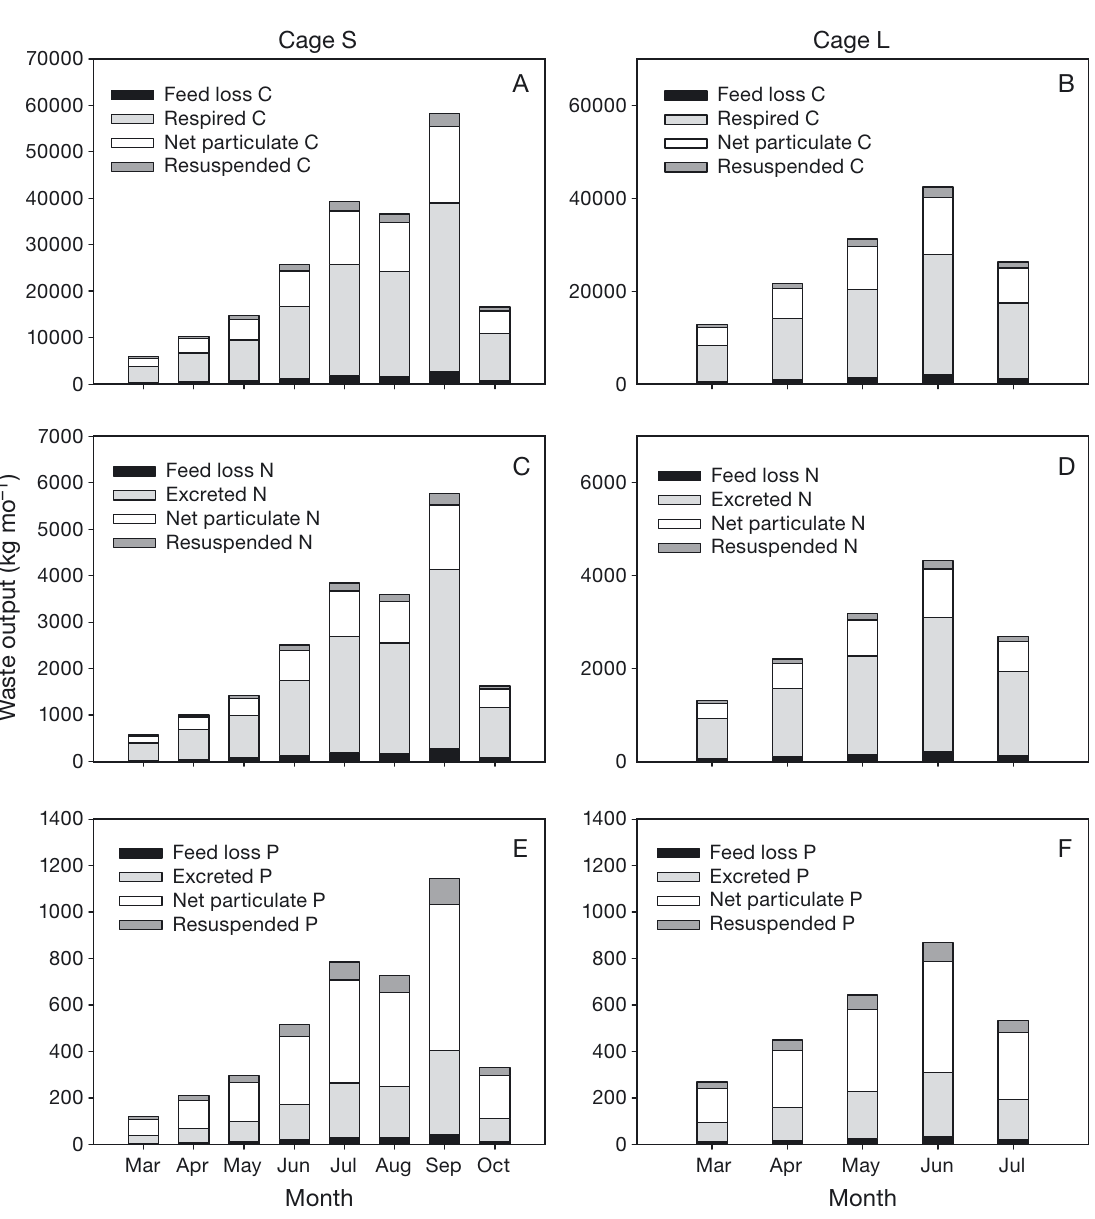
Fig. 9. Model estimates of different C, N and P waste outputs from Cage S (from March to October) and Cage L (from March to July) fish fed on commercial feed pellets. (A) C mass balance for Cage S; (B) C mass balance for Cage L; (C) N mass balance for Cage S; (D) N mass balance for Cage L; (E) P mass balance for Cage S; and (F) P mass balance for Cage L. All values were based on dry